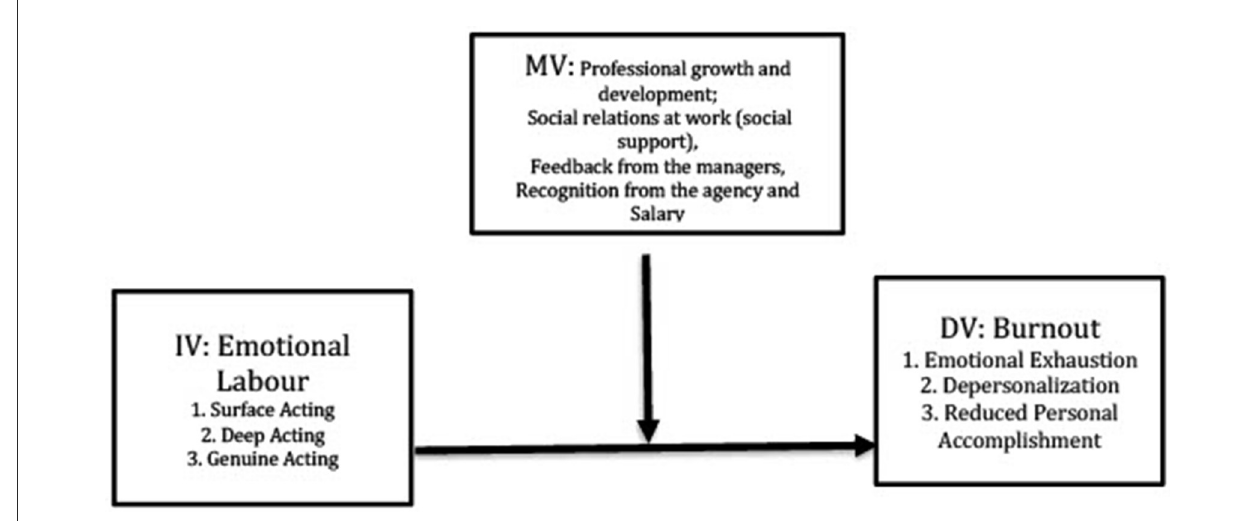
FIGURE1 Research model: EL impact on social workers’ burnout.